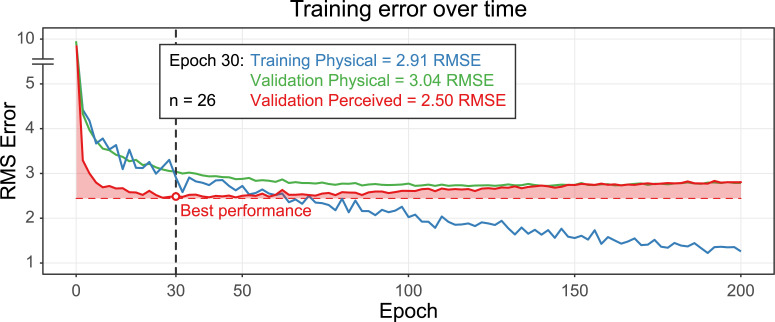
Mean training and validation error (y-axis) as training time increases (x-axis) across 26 individually trained networks. The 100 networks used in this study are trained for only 30 epochs since the perceived viscosity prediction error increases as training continues. The Validation Perceived shows larger errors than in the previous figures and results because here we do not average across variations for a clean comparison with the training results.